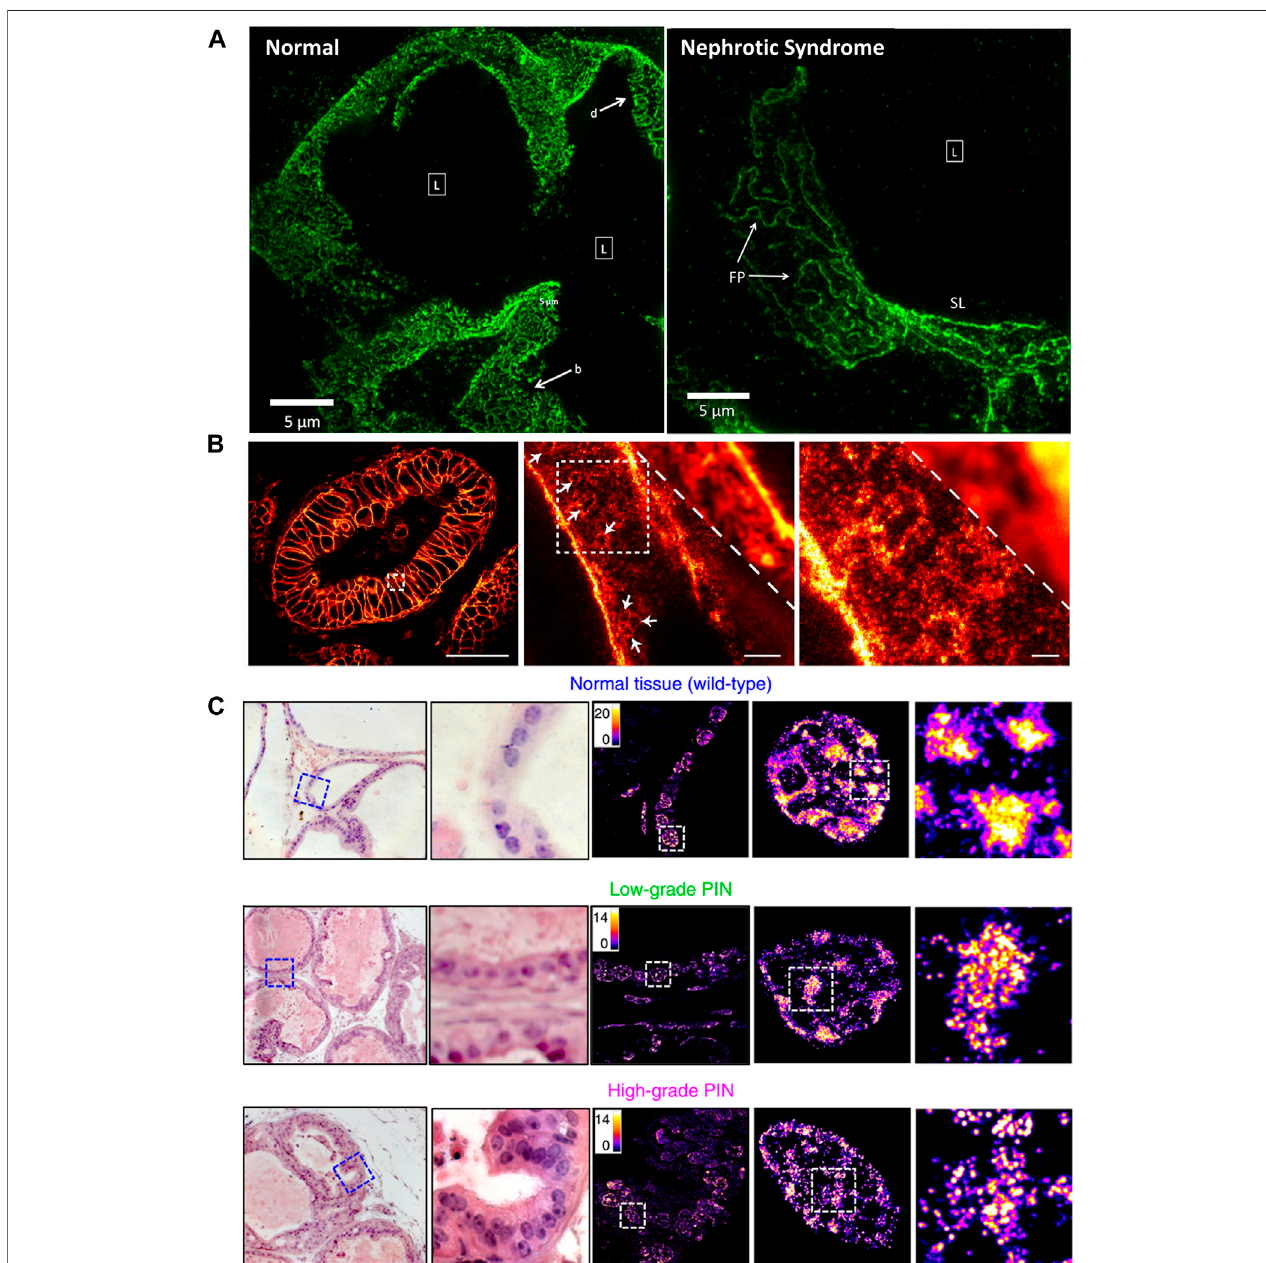
FIGURE 9 | Applications of SRMs in pathobiology. (A) Comparison of podocin-stained renal biopsies form normal and nephrotic disease tissue slice by SIM technology (Pullman et al., 2016). Scale bar: 5 µm. Reprinted from Pullman et al. (2016) with permission from the Optical Society of America. (B) The diffraction-limited image and STED super-resolution image on sectioned stored tissue of human rectal cancer (Ilgen et al., 2014). Scale bars: 50 µm in original image, 2 µm in magni fi ed images. Reprinted from Ilgen et al. (2014) with permission from Public Library of Science. (C) Visualization of disrupted heterochromatin structures in prostate neoplasia by PathSTORM (Xu J. et al., 2020). Reprinted from Xu et al. (2020) with permission from Springer Nature.